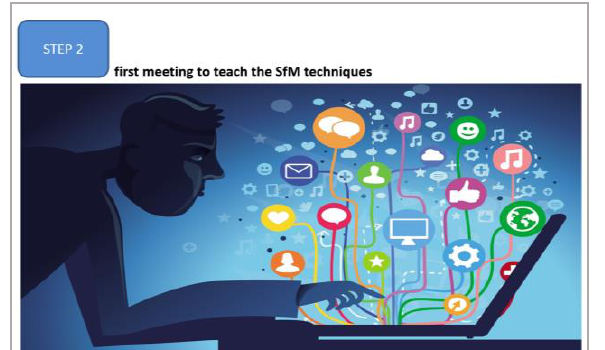
Figure 11. The tutorial lesson aimed at learning the SfM techniques: step 2